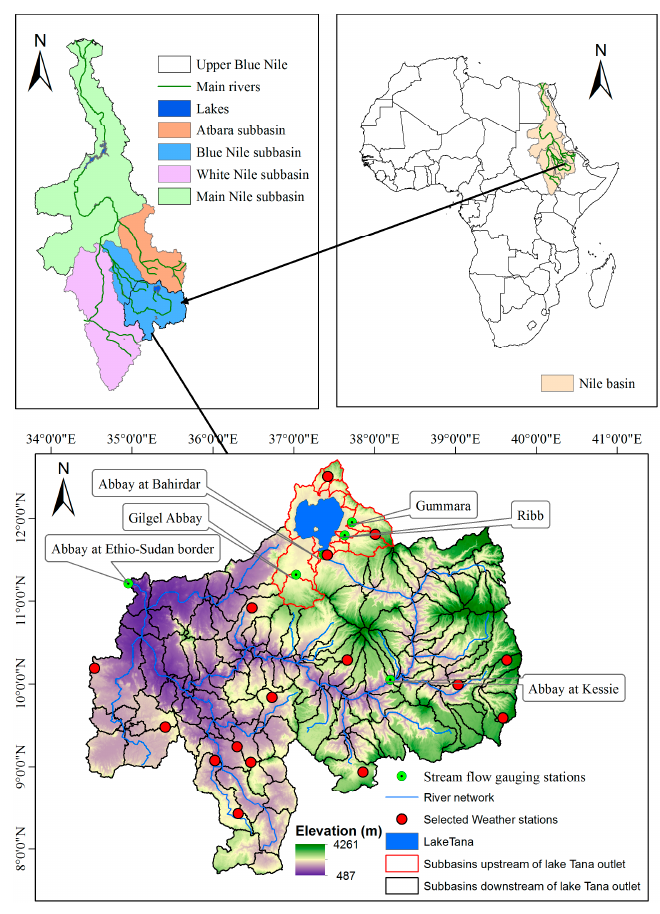
Figure 1. Upper Blue Nile basin with river network, gauging stations, and the sub-basin discretisation used by the Soil and Water Assessment Tool (SWAT) model to estimate soil moisture and actual evapotranspiration (Section 2.2.2), upstream and downstream of the Lake Tana outlet.